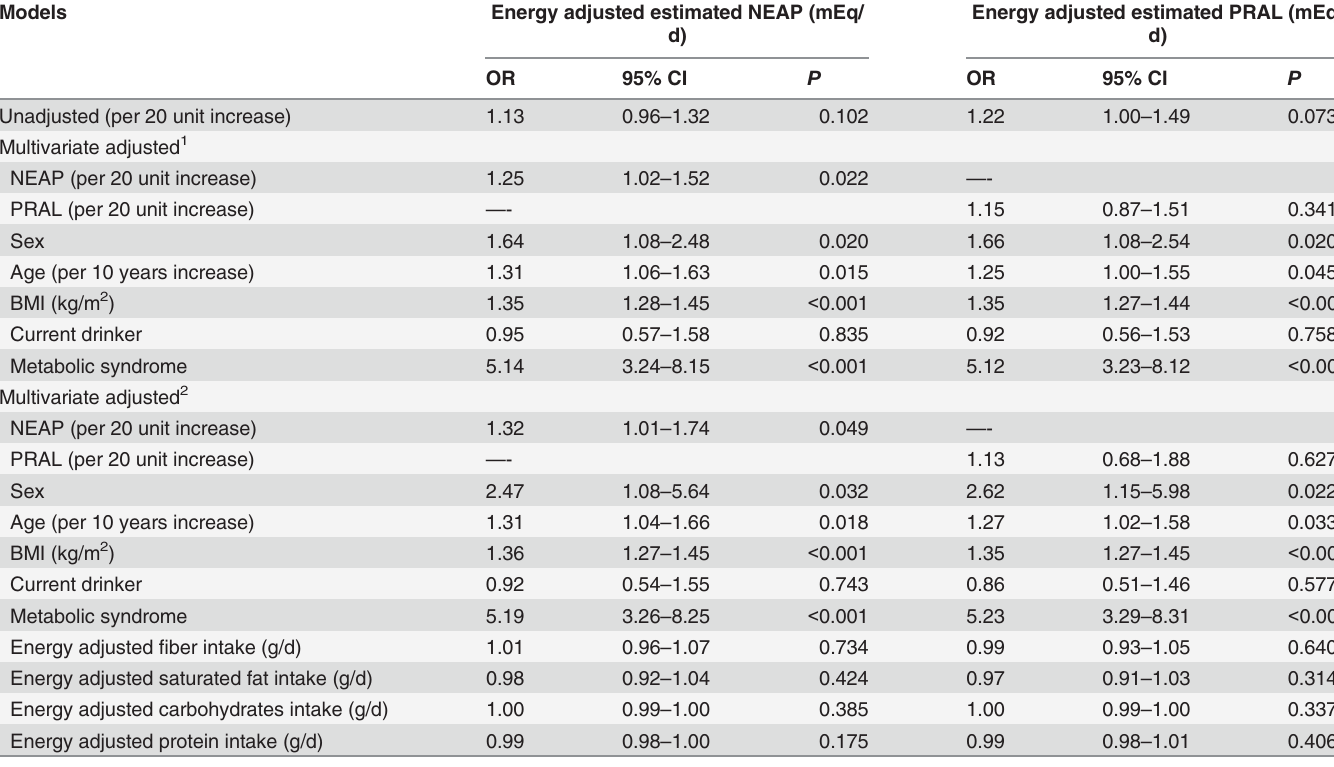
Table 4. Logistic regression linking NEAP or PRAL and the presence of NAFLD (n = 793).